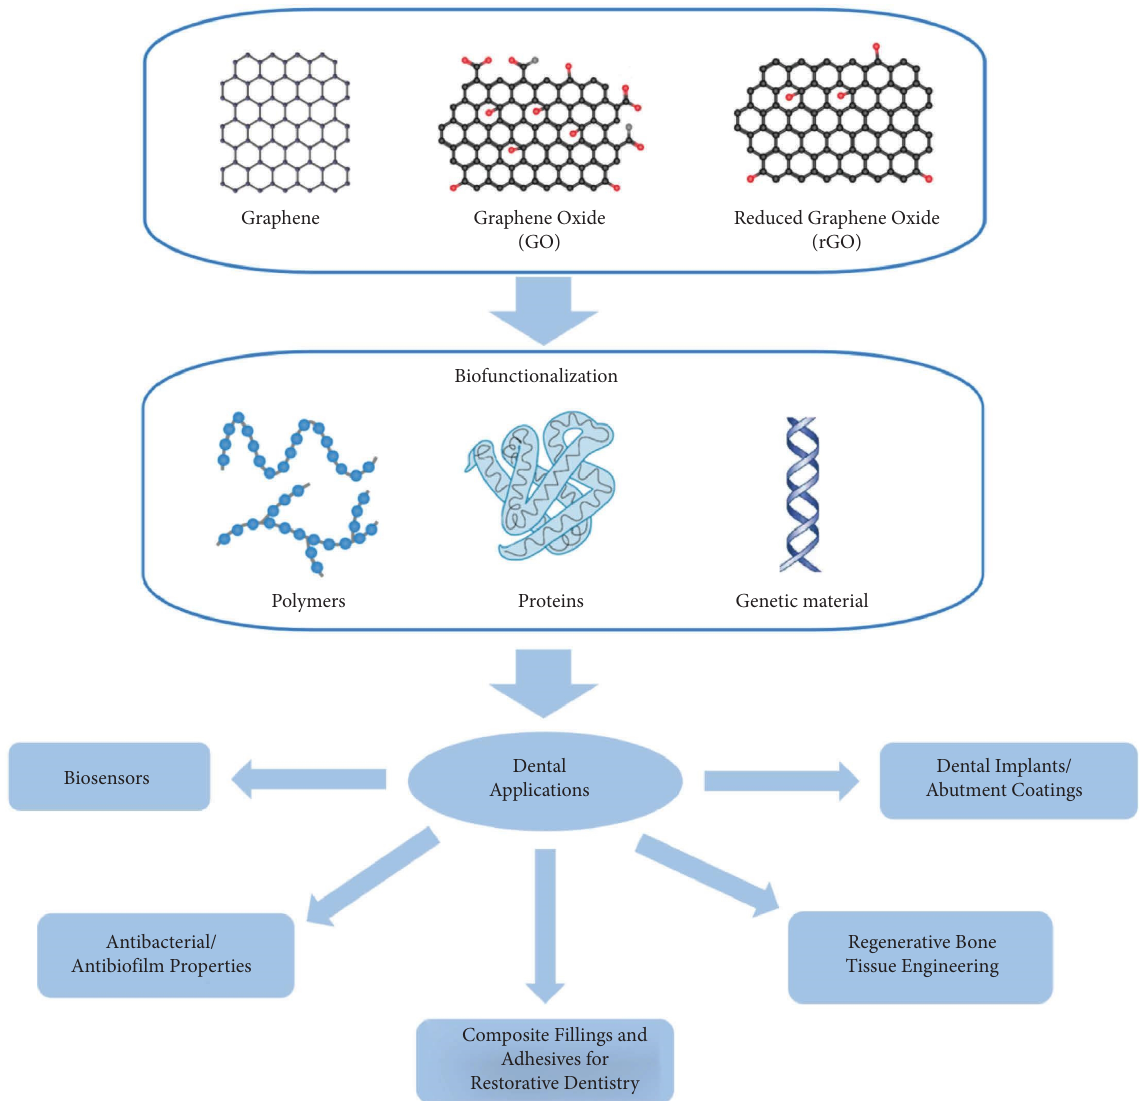
Figure 4: Graphical abstract of graphene-based materials for dental